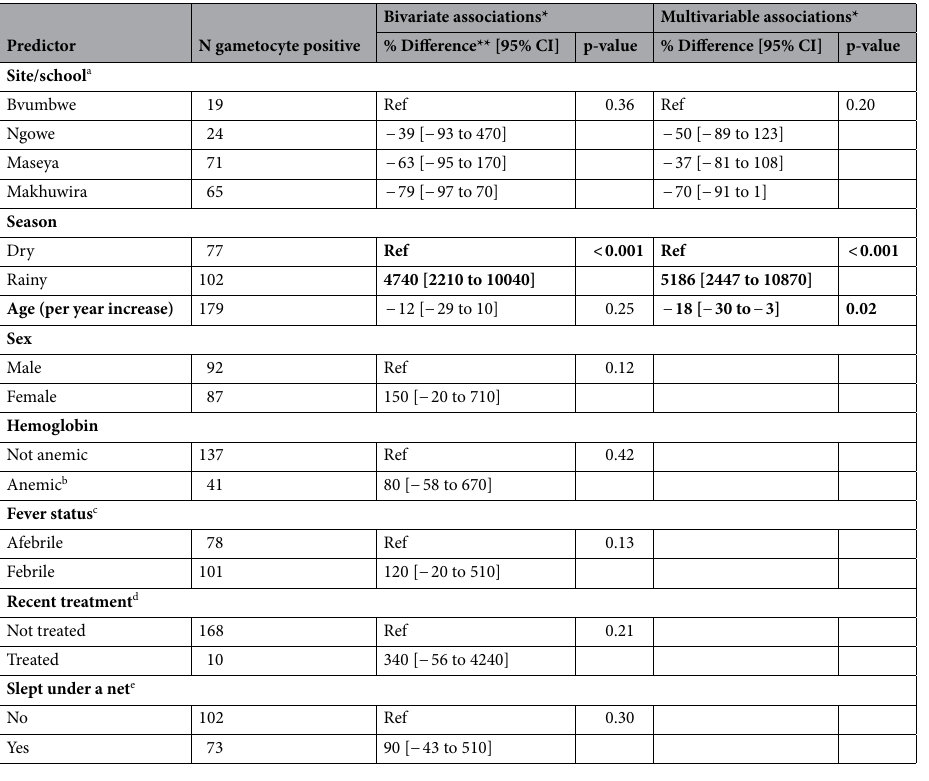
Table 2. Predictors of baseline gametocyte density among infections containing gametocytes in the school cohort. *Obtained in a survey weighted (weights calculated by school*standard) linear regression with logarithm transformed gametocyte density as an outcome, and analyzing the variables shown in the table. **Percent difference in gametocyte density from reference category is calculated as: [exp(coeff) − 1] × 100. OR = Odds Ratio; CI = Confidence Interval. Bold values are statistically significant for p-values < 0.05. a Univariate association for school, all bivariate include adjustment for school. b Hemoglobin < 11.0 g/dL; 1 missing observation. c Measured temperature ≥ 37.5 °C at baseline visit or reported in the last two weeks. d Reported in the last two weeks; 1 missing observations. e 4 missing